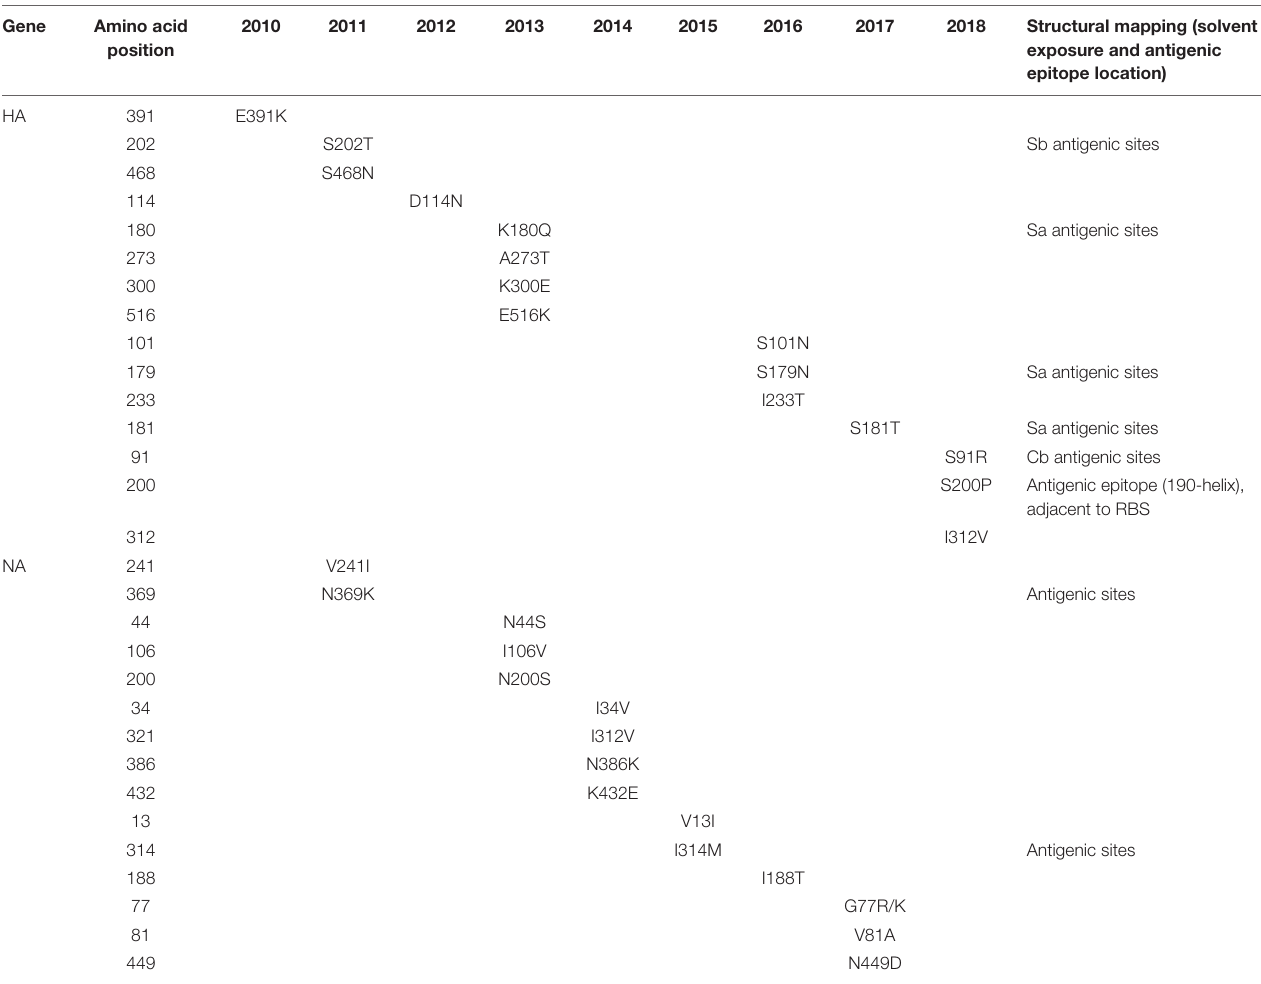
TABLE 2 | Amino acid variations along the major trunk of the phylogenetic trees of A/H1N1pdm virus HA and NA glycoproteins over time. Gene Amino acid